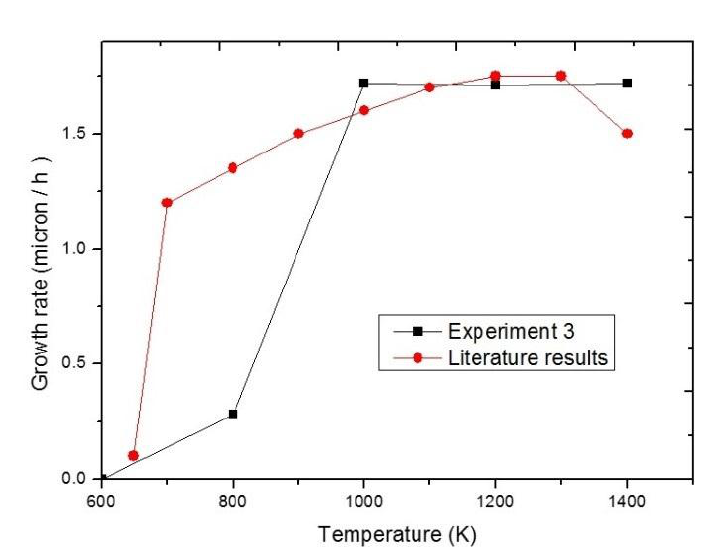
Figure 19. Schematic diagram of mesh for Experiment 3 [13].